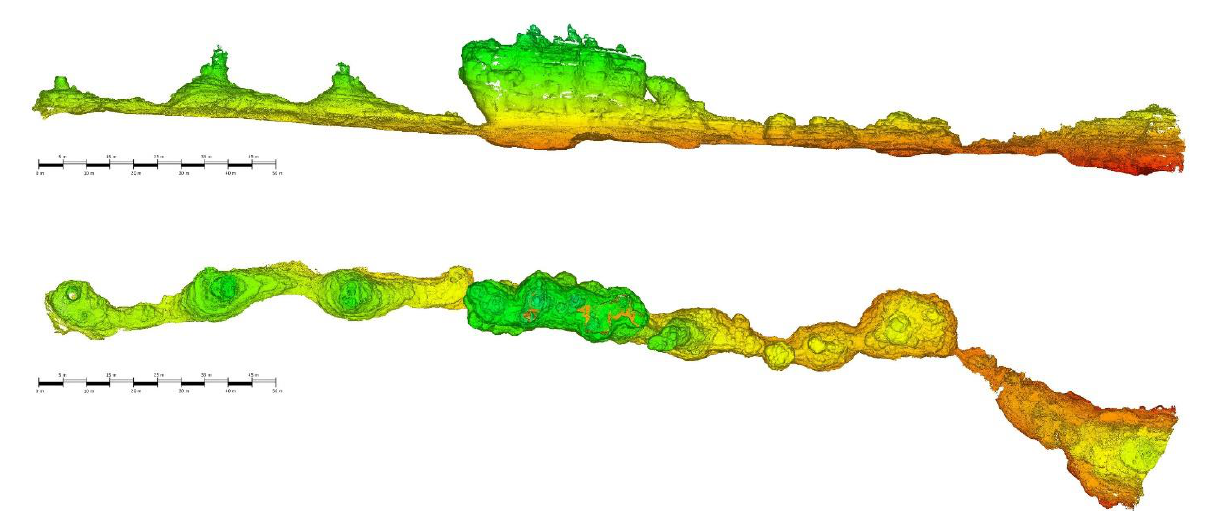
Figure 7. View of the overall model in elevation mode (RGB false